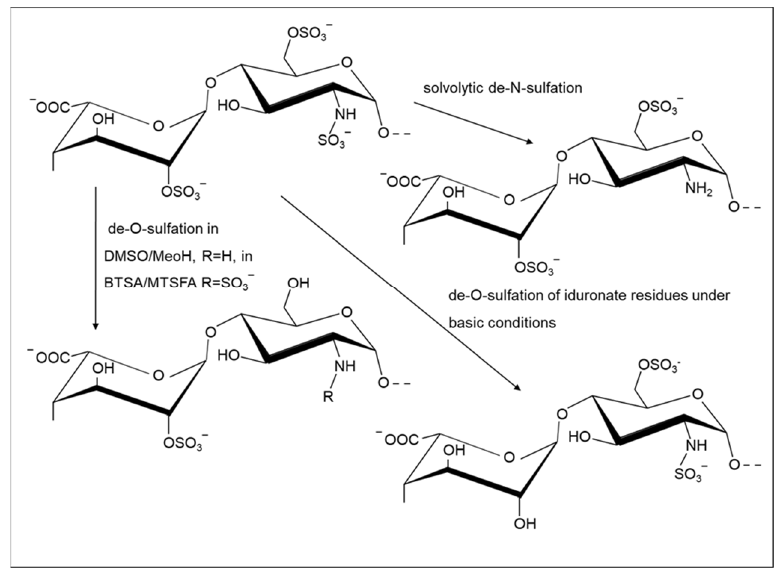
Figure 2. De - O and N - sulfation reactions in heparin, combinations which allow systematic modifi- Figure 2. De- O and N -sulfation reactions in heparin, combinations which allow systematic cation of the substitution patterns of heparin at I - 2, A - 6, and A - 2 positions.